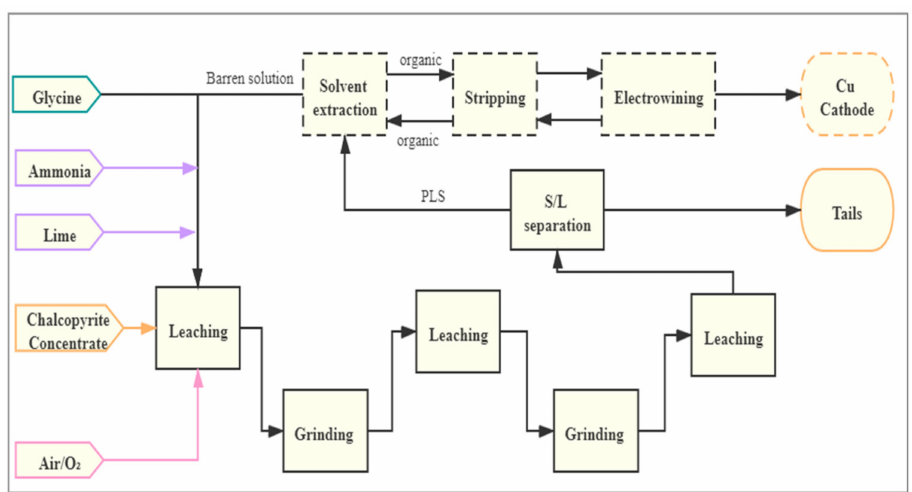
Figure 10. Block diagram of the conceptual process for chalcopyrite leaching using a glycine– ammonia lixiviant